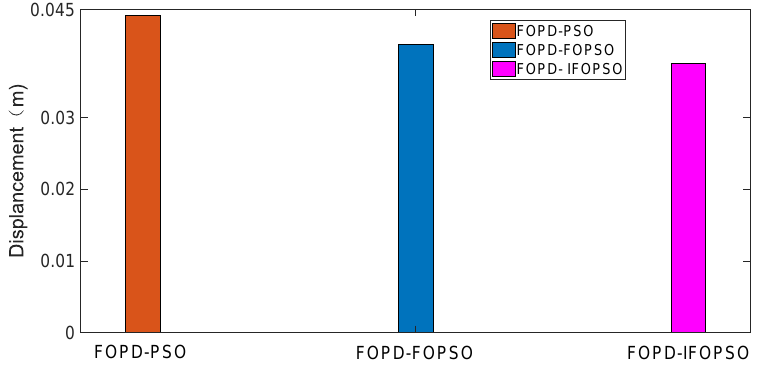
Figure 6. Maximum displacement for the three algorithms under earthquake seismic wave